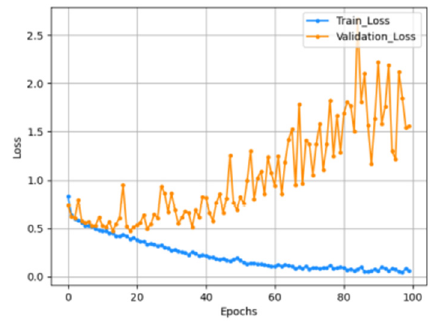
Figure 7. Accuracy graph.